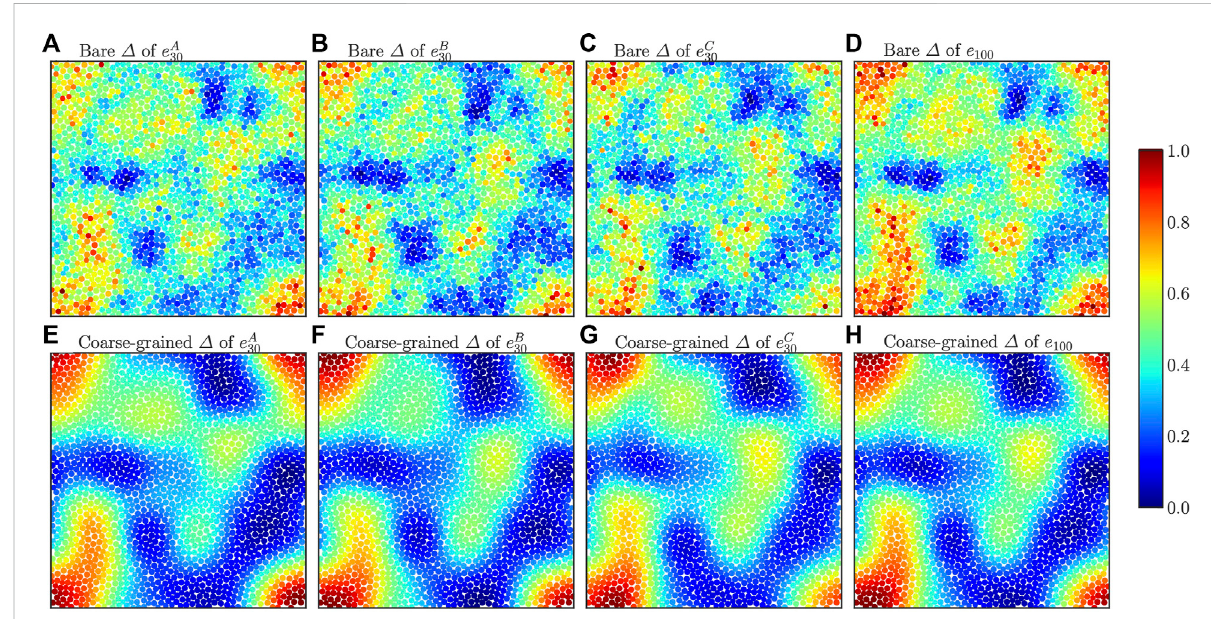
FIGURE 4 Comparisons between the bare and the coarse-grained dynamic propensity fi elds Δ of different ensembles. The results of Δ (1.0) of the KA system are shown. (A – C) The bare Δ fi elds of e i 30 ( i ∈ { A , B , C }) , (D) the bare Δ fi eld of e 100 , (E – G) the coarse-grained Δ of e i 30 , and (H) the coarse- grained fi eld of e 100 . The coarse-graining length of ξ Δ = 4.0 is employed as in Figure 1E.